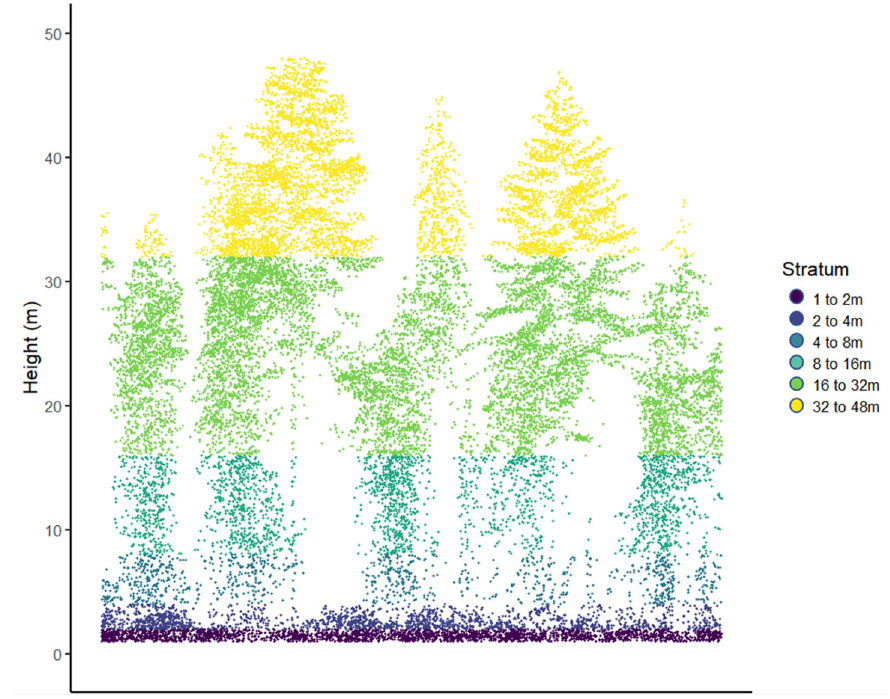
Figure 1. Example LiDAR point cloud with height strata, shown in different colors, used in the analysis.